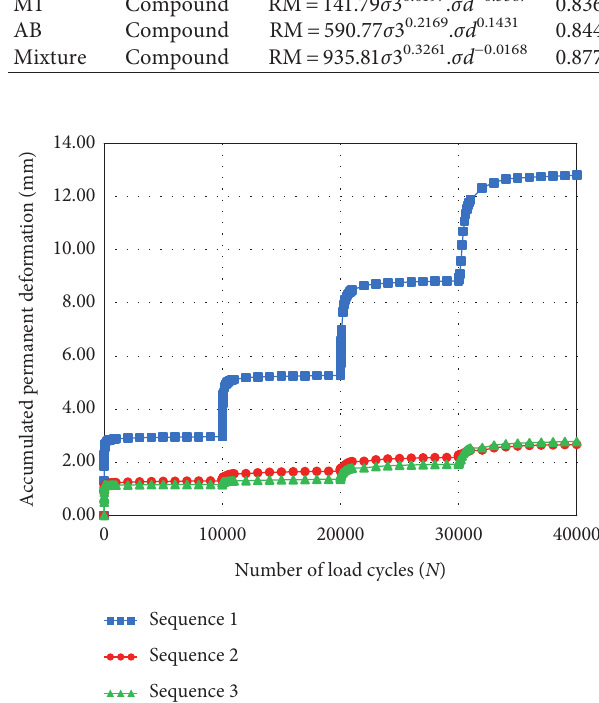
Figure 3: Accumulated permanent deformation measured from the RLT tests of the M1